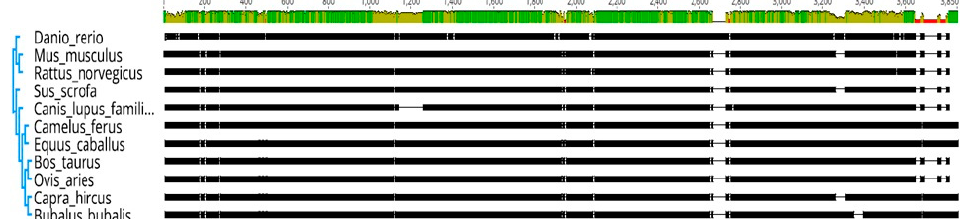
Figure 2. Phylogenetic tree with alignment view of HSP40 (sequence 1–493), HSP70 (494–1137) and HSP90 (1138–1870), HSPB (1871–2087), HSPD (2088–2662), HSPH1 (2663–3588) and HSP10 KD (3589– 3850). Percentage of sequence identity is represented with different colors in identity bar at top of the sequences green color indicates 100% identity, green-brown shows at least 30 and under 100% while red representing below 30 identity.